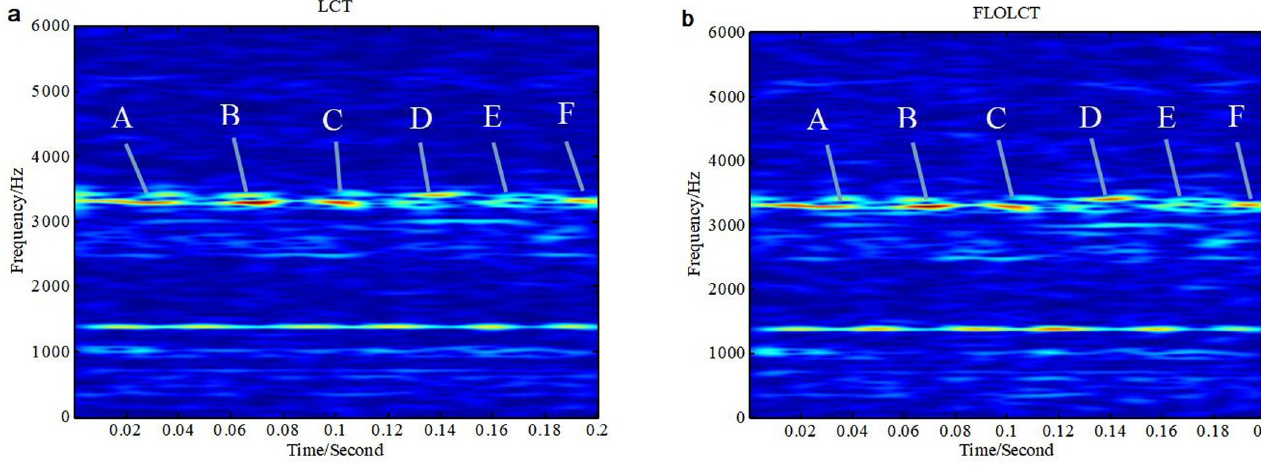
Fig 9. The time-frequency representations of the bearing ball fault in the position of DE data contaminated by Gaussian noise ( SNR = 5 dB ). (a. LCT time- frequency representation ( c = 5); b. FLOLCT time-frequency representation ( c = 5, p = 1.2)).